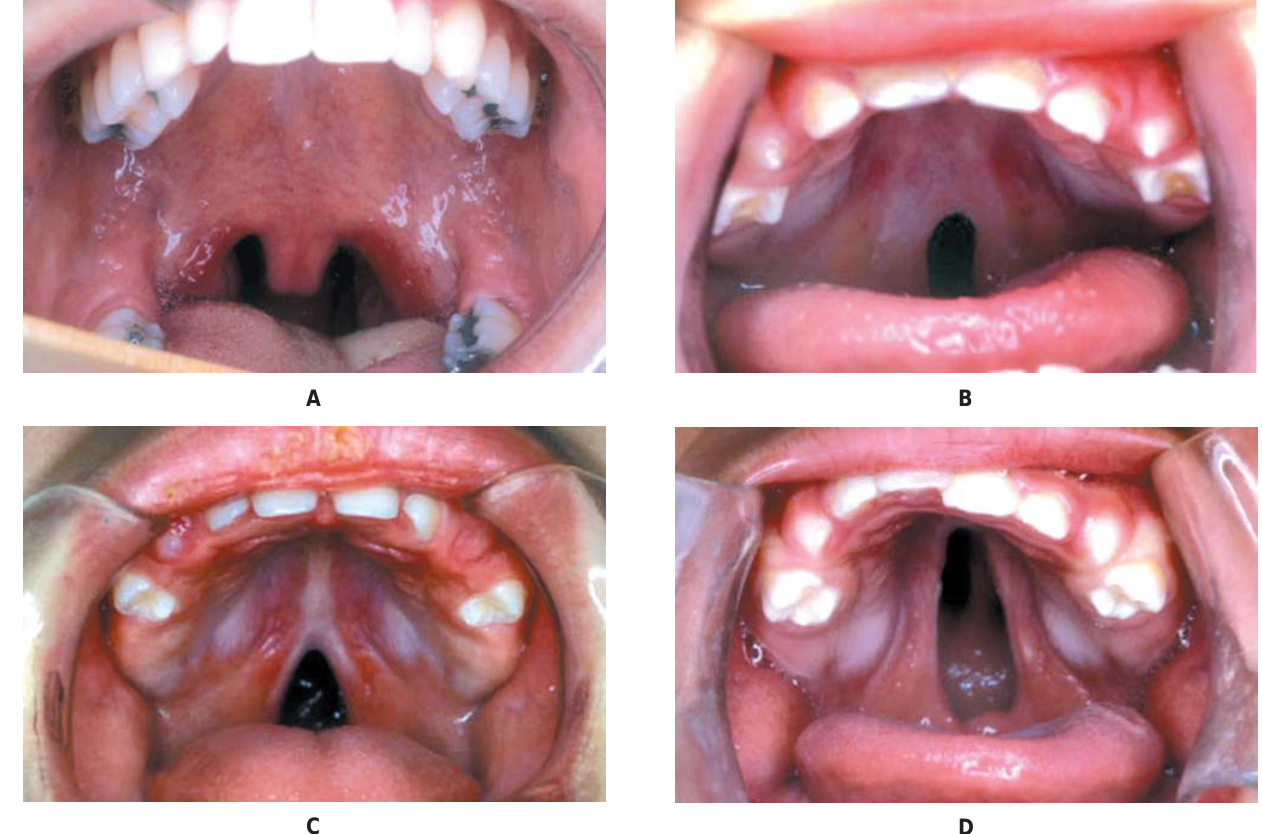
FIGURE 1- Different extents of isolated cleft palate: A) uvula, B) soft palate, C) incomplete hard palate and D) complete hard